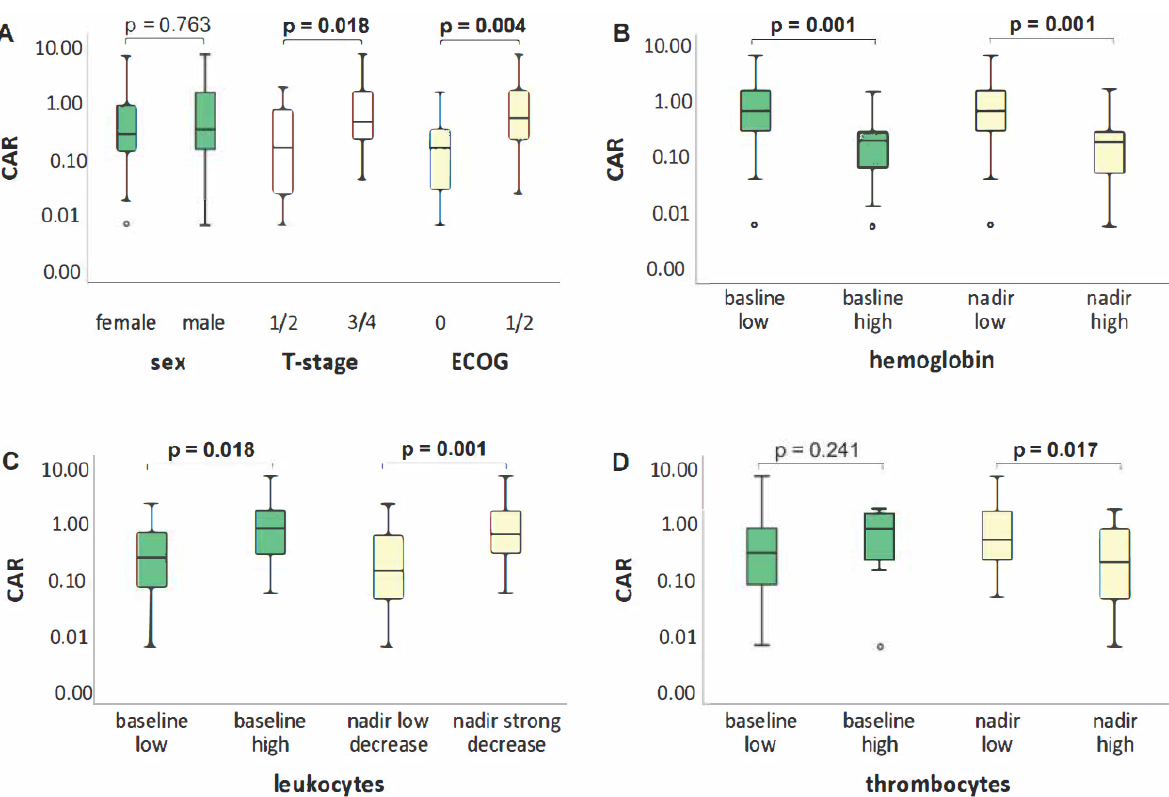
144 (10–305) Abbreviations: BMI, body mass index; ECOG, Eastern Cooperative Oncology Group Performance Status; NOS, not otherwise specified; CRT, chemoradiotherapy; CT, chemotherapy; Gy, Gray; CRP, C-reactive protein; CAR, CRP to albumin ratio; GPS, Glasgow Prognostic Score. Higher T-stage (T1/2 vs. T3/4, p = 0.018) and poorer performance status (≥ECOG 1, p = 0.004) were significantly associated with elevated baseline/pre-treatment CAR, whereas N-status (N0/1 vs. N2/3), sex, BMI (cut-off: 25 kg/m²) and histology (adeno and squamous cell) were not ( p = 0.265, p = 0.763, p = 0.971 and p = 0.155) (Figure 1A). We examined associations between CAR as a continuous variable with baseline blood count and blood count at the patient-specific nadir. Significantly higher leukocyte counts (cut-off: 10/nL, p = 0.018) and lower hemoglobin levels (sex-specific cut-off for men: